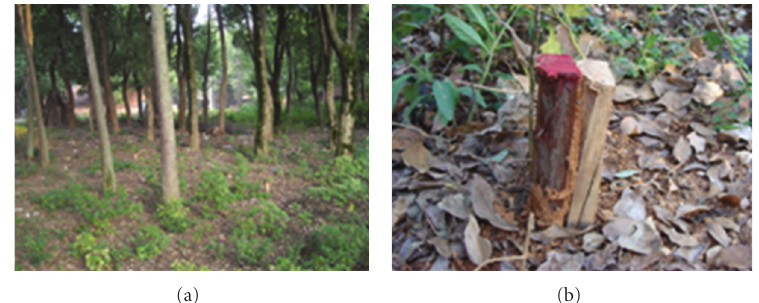
Figure 2: Grove of camphor trees with pairs of sampling stakes: (left) pair of sampling stakes.